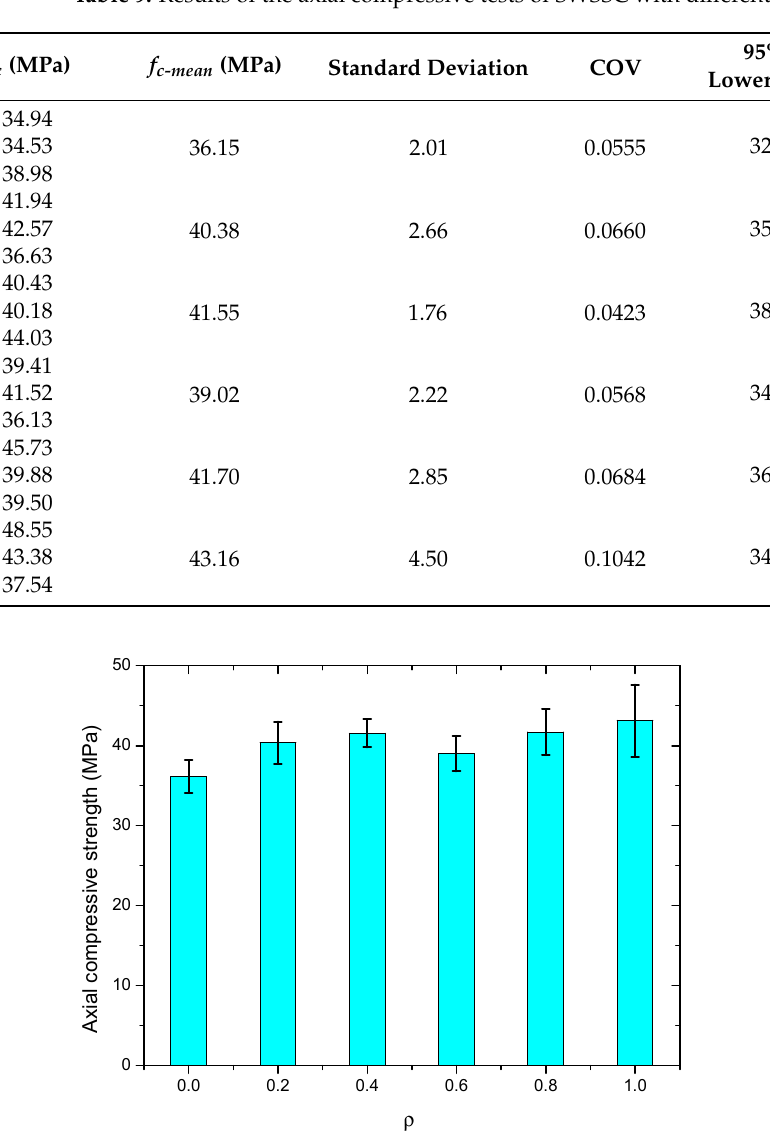
Table 9. Results of the axial compressive tests of SWSSC with different mixes.